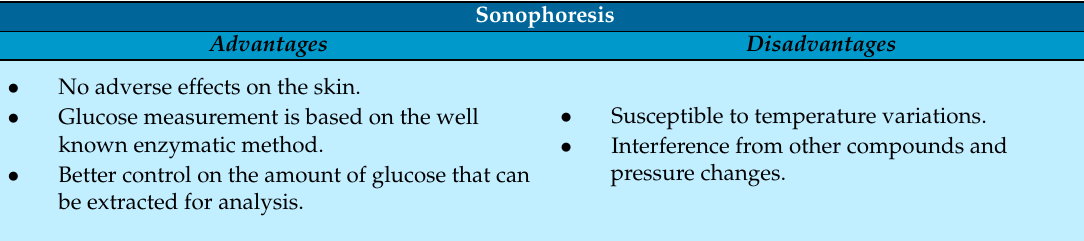
Table 21. Advantages and disadvantages of sonophoresis.